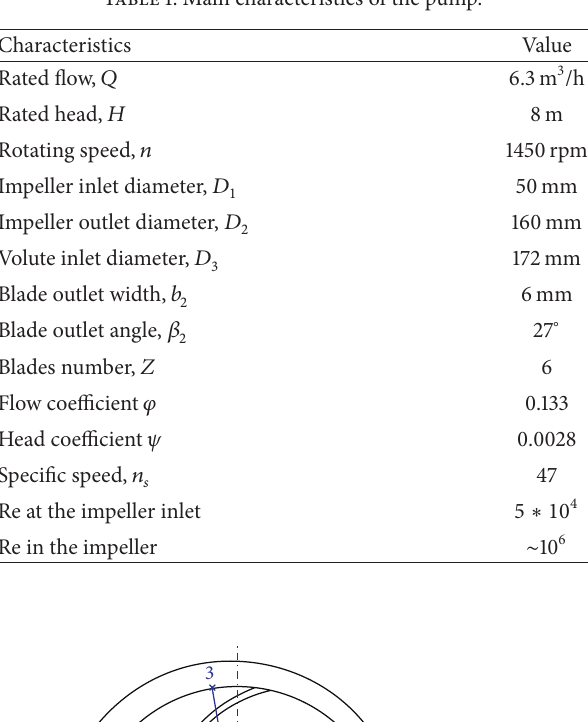
Table 1: Main characteristics of the pump.